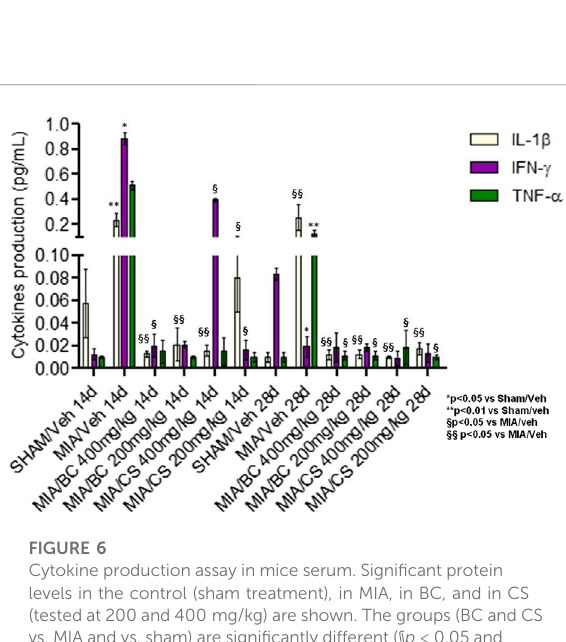
FIGURE 6 Cytokine production assay in mice serum. Signi fi cant protein levels in the control (sham treatment), in MIA, in BC, and in CS (tested at 200 and 400 mg/kg) are shown. The groups (BC and CS vs. MIA and vs. sham) are signi fi cantly different (§ p < 0.05 and §§ p < 0.01, and * p < 0.05 and ** p < 0.01) according to Student ’ s t